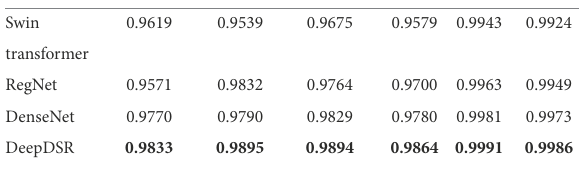
TABLE 4 The performance comparison of DeepDSR and three individual models for binary classification problem. Precision Recall Accuracy